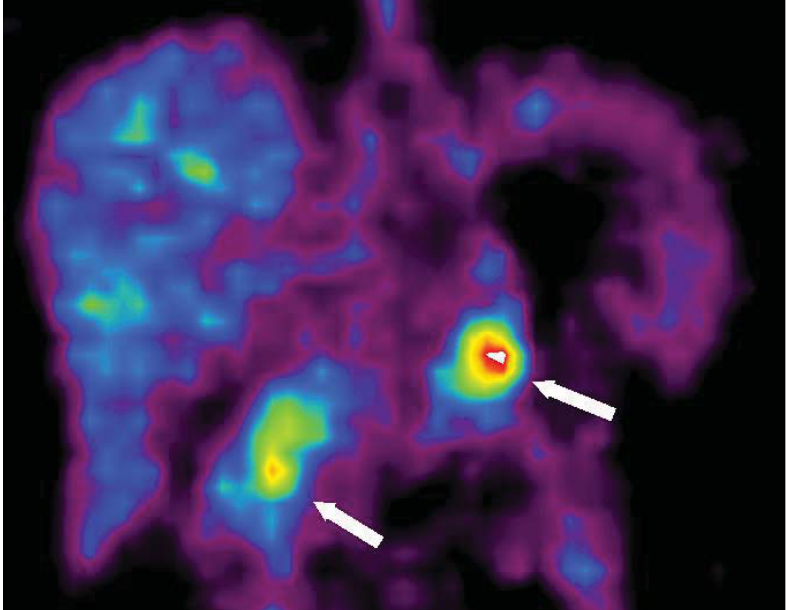
Figure 3. Coronal 11 C-5-HTP PET image of a patient with a MEN-1 syndrome and biochemical signs of a pancreatic tumor (patient 2). Two pancreatic tumors, one in the head and one in the tail, were seen at PET and were both later confirmed by surgery. The tumors in the head as well as the tail of the pancreas are clearly depicted (arrows: to the right = pancreatic head; to the left = pancreatic